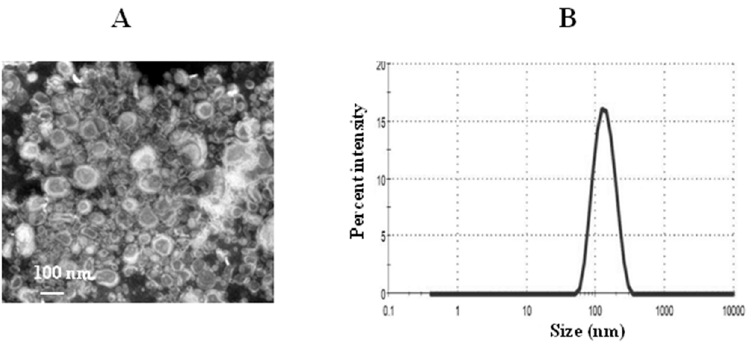
Figure 6. Characterization of liposomes. ( A ) A transmission electron microscopy (TEM) image of TQ liposomes, ( B ) size of TQ liposomes.